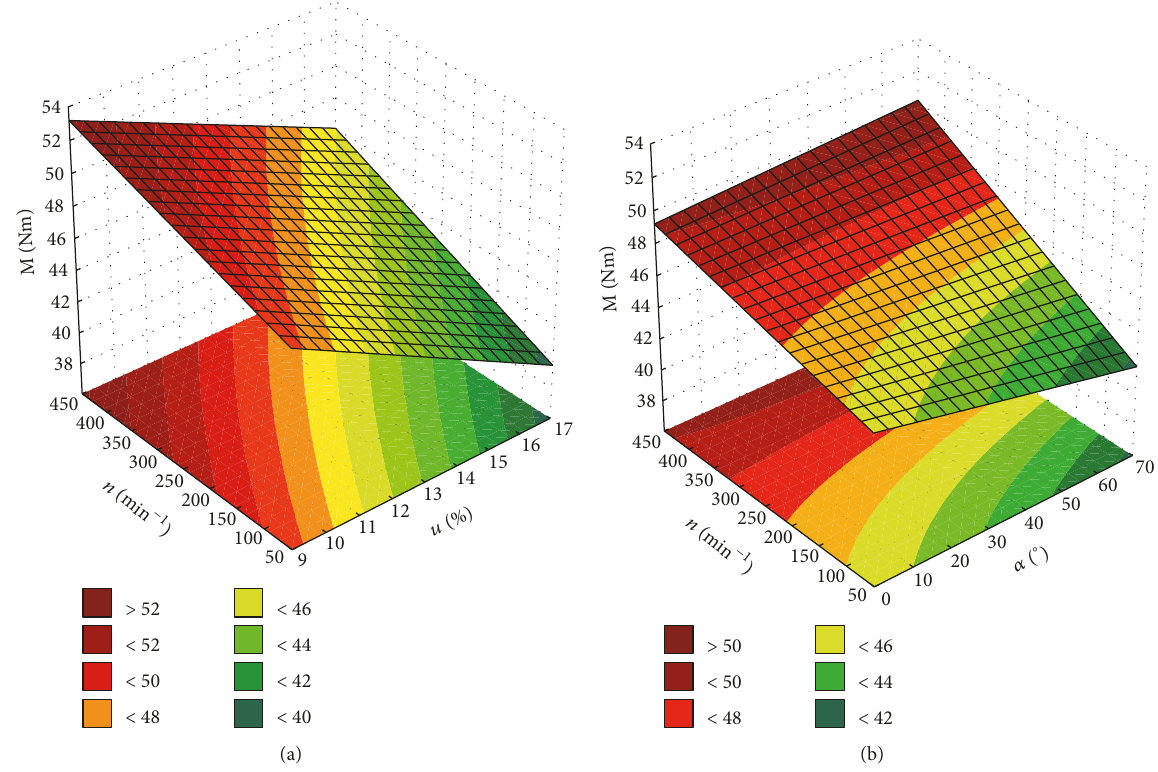
Figure 5: Model of the screw drive torque M, response surface versus the screw rotational speed n and (a) talc mass fraction u, (b) angle between the kneading elements 𝛼 .